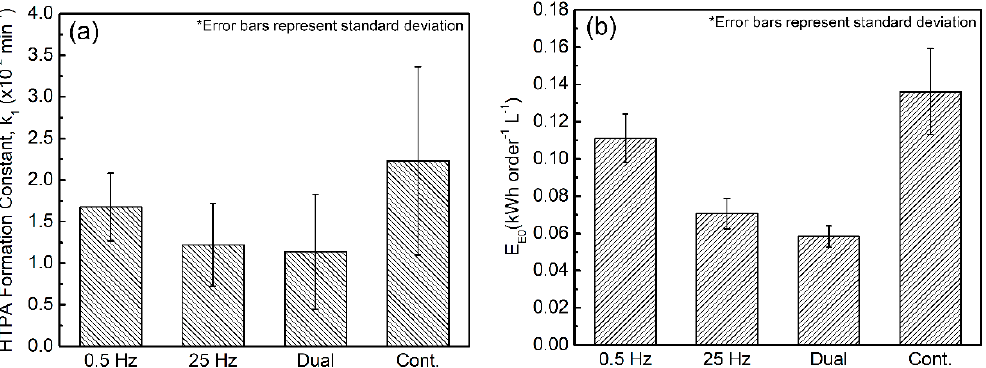
Figure 1. ( a ) Rate constants and ( b ) electrical energy per order for terephthalic acid (TPA) conversion under various UV-LED